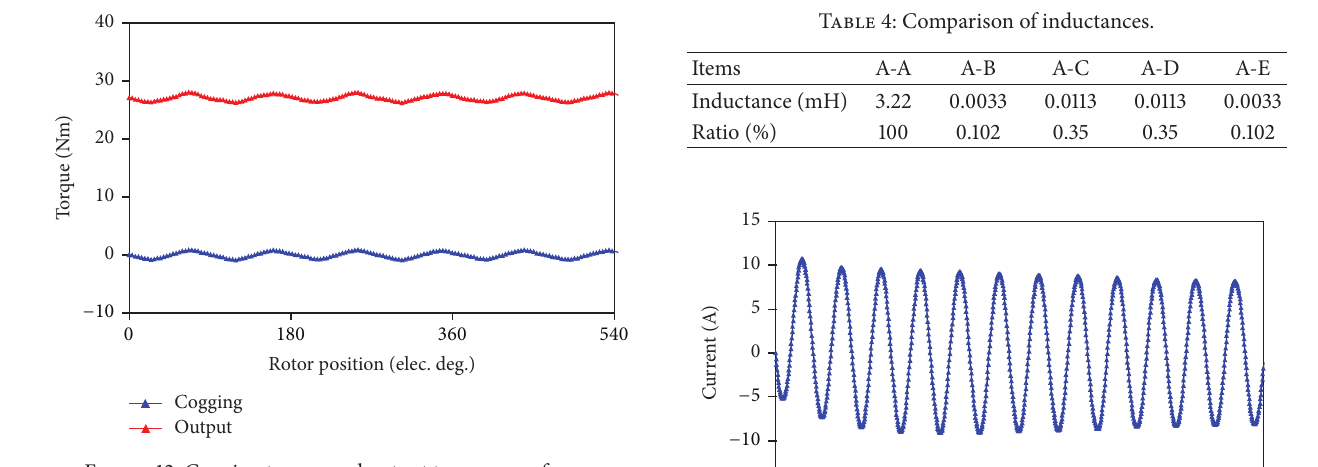
Figure 12: Cogging torque and output torque waveforms.